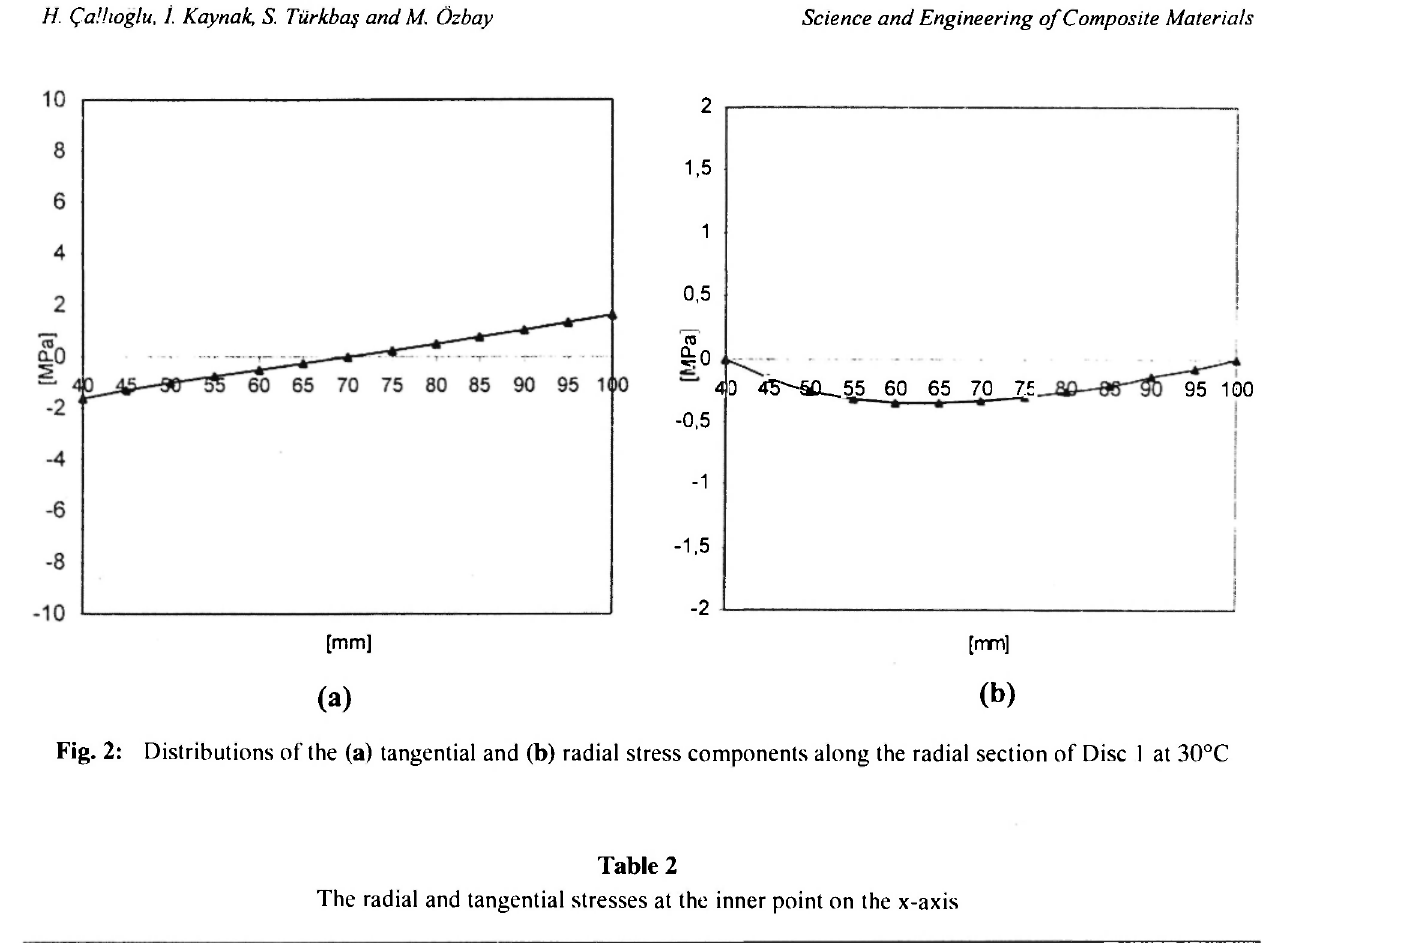
The radial and tangential stresses at the inner point on the x-axis